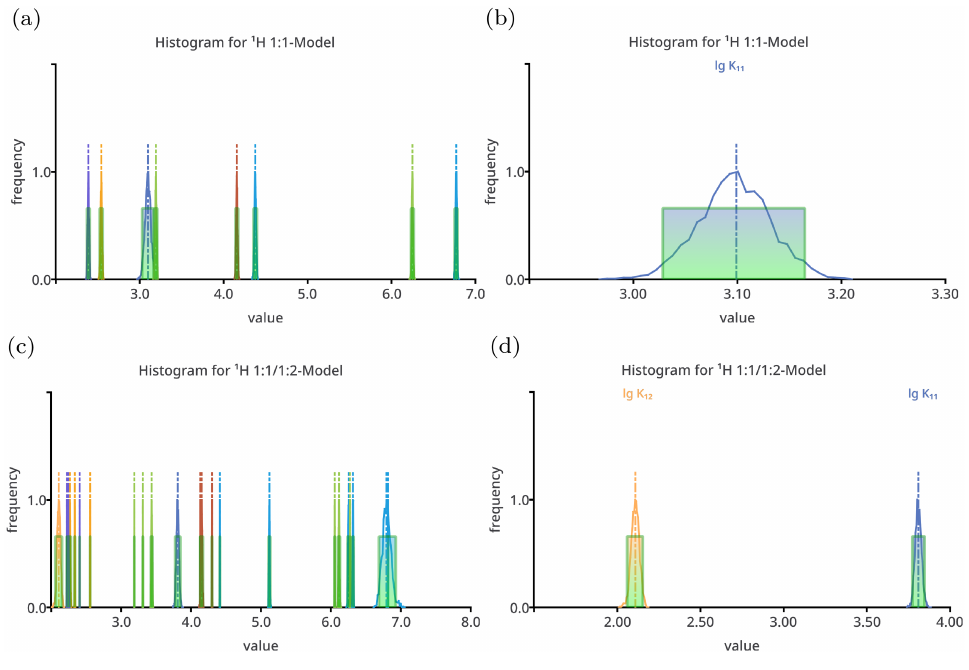
Figure 1 Histogram like charts after performing Monte Carlo simulation on top of the best-fit 1:1 model (A, B) and the best-fit 1:1/1:2 model (C, D) fitted to the simulated titration curve with 1:1/1:2 stoichiometry . The charts in (A) and (C) show all model parameters, the dimensionless stability constants as log10 and chemical shifts in ppm, which is the standard way to plot Monte Carlo simulation histograms in SupraFit . The charts (B) and (D) show only the stability constant, with the corresponding parameter name above the curve. Apart form the incorrectly estimated value of lg K 11 in the 1:1 model, the distribution of the ‘‘observed’’ stability constants and chemical shifts are narrow and do not indicate an inappropriate model. Full-size DOI: